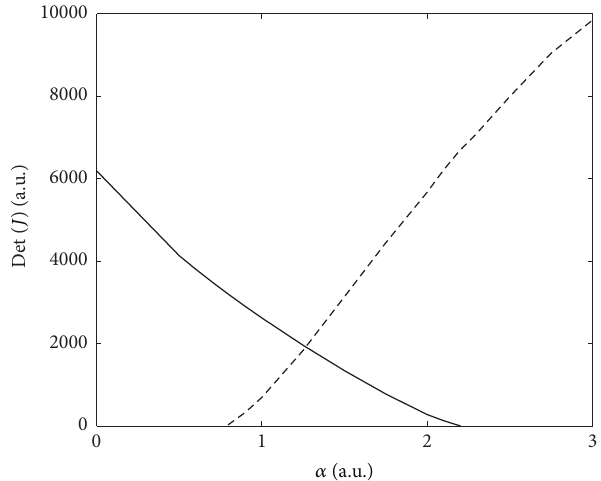
Figure 8: Saddle-node bifurcation illustrated by means of the Figure 10: Determinant of the Jacobian matrix 𝐽 as computed from cubic fixed point equation (19). The functions 𝑓 𝐿 (solid line) and V at the saddle-node 𝑓 (4) and (22) for the state 𝑥 (low), 𝑦 (high) (solid line) and the state 𝑅 (dashed line) of (19) are plotted versus 𝑥 (high), 𝑦 (low) (dashed line) shown in Figure 5 and as function of bifurcation point in which the state 𝑥 (low), 𝑦 (high) emerges or 𝛼 . Parameters: 𝐵 = 𝐷 = 1 ; all other parameters are as in Figure disappears. Parameters: 𝛼 = 2.2 ; all other parameters are as in Figure 5.